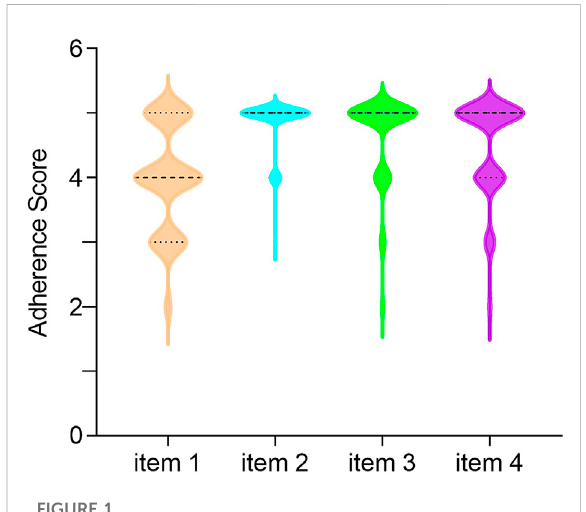
FIGURE 1 The distributions of scores for each item of